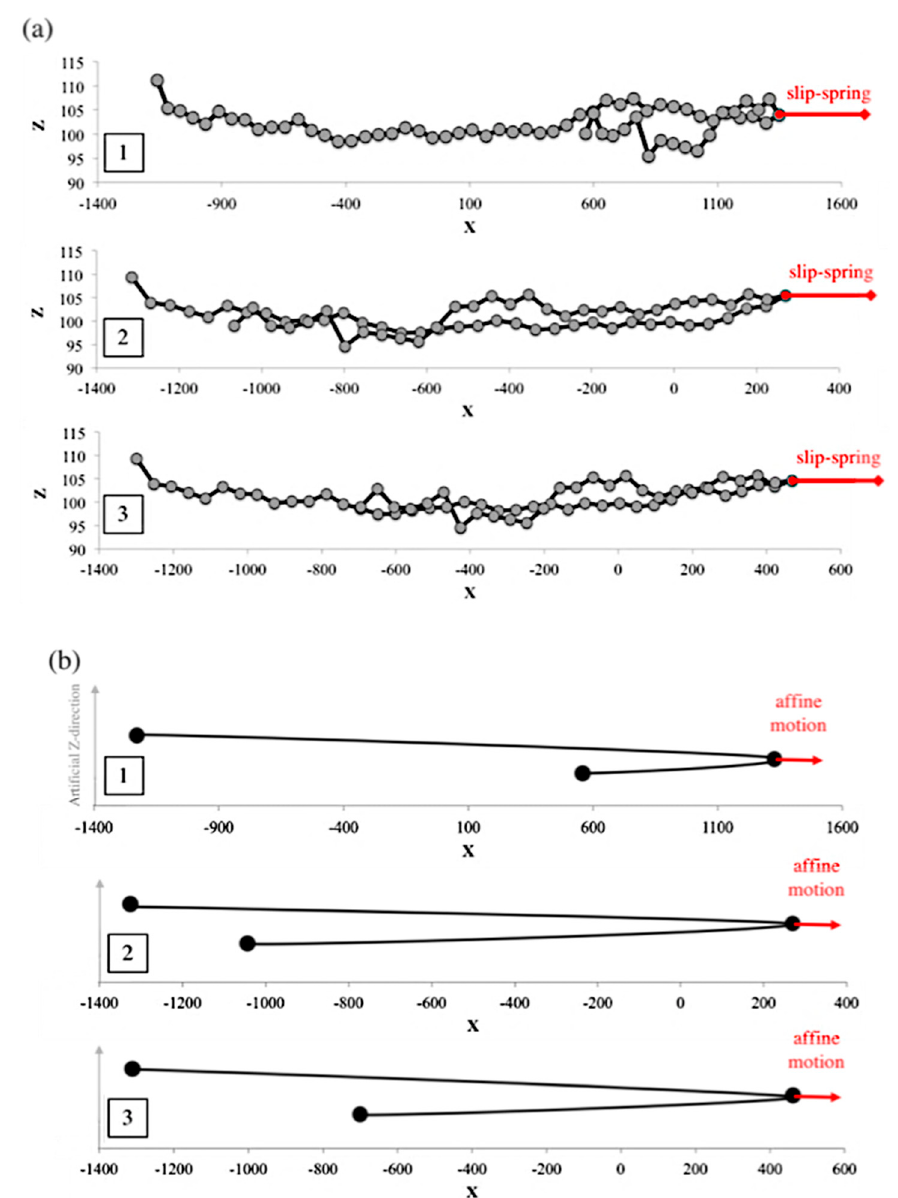
Figure A1. Three conformations used to compare the unraveling behavior of a chain from the kinked to fully unraveled state in ( a ) the slip-spring simulations and ( b ) kink dynamics simulations. In the slip-spring simulations, N s = 64 and the maximum applied force, F max ss = ζ (cid:48) ˙ (cid:101) L 2 /8, is applied. In the kink dynamics simulations, affine motion is imposed at the kink.